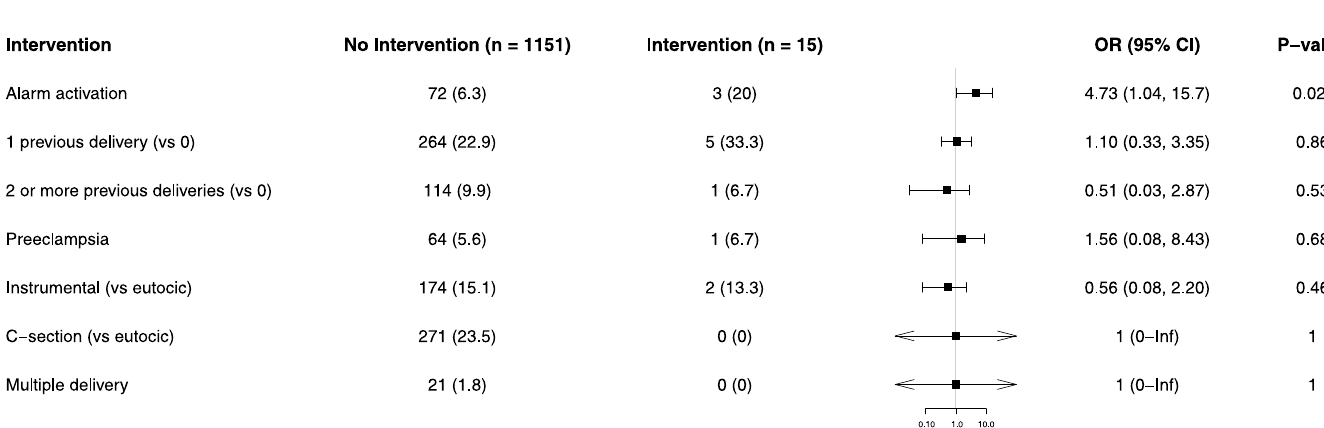
Fig 2. Forest plot of multivariate logistic analysis of the influence of MEWC activation, patient comorbidity and delivery on PFD. We present the results as an odds ratio with a 95% confidence interval. Results less than 1, left of the y-axis, imply risk reduction. We accepted p < 0.05 as significant.